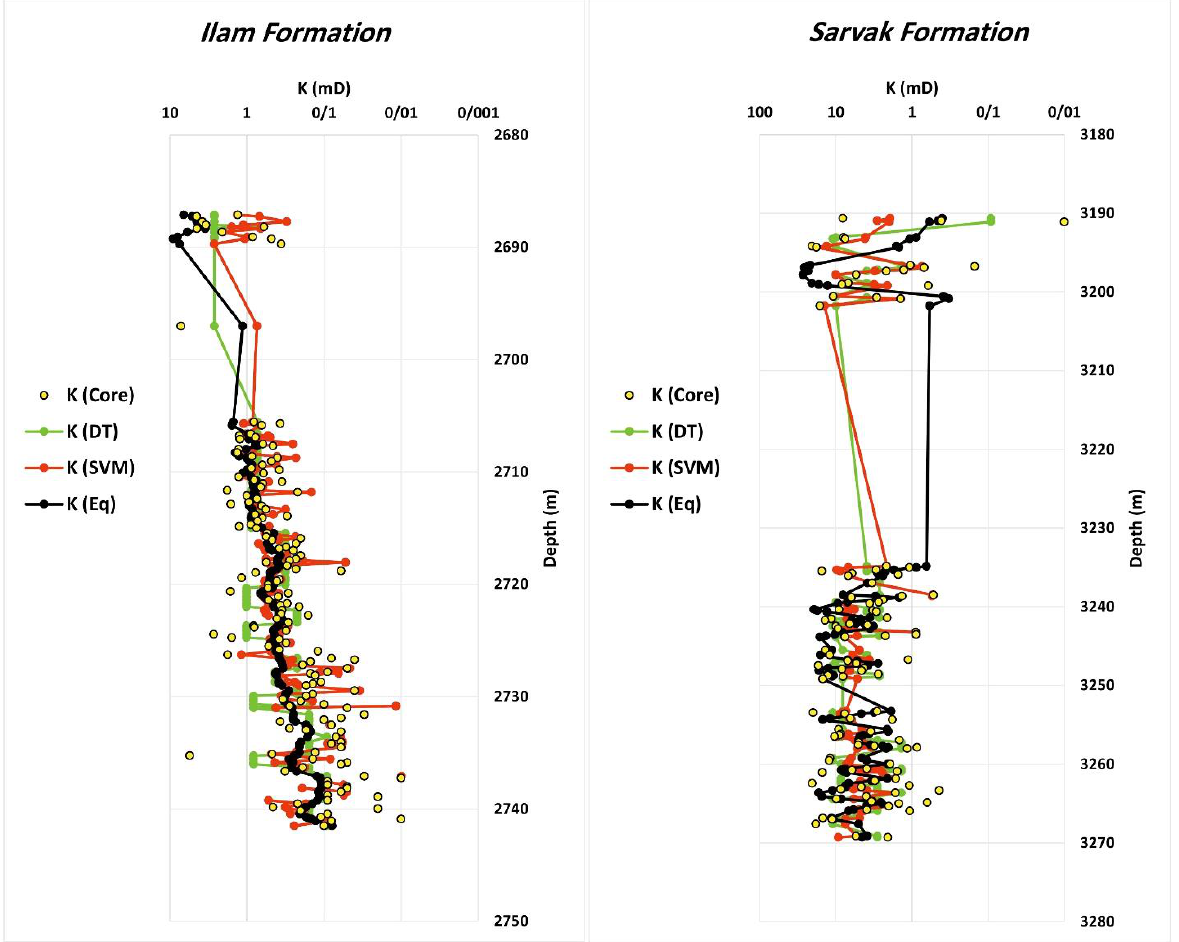
Figure 13. The variation of obtained permeability values by the empirical equation, SVM, and DT quantities with depth for Ilam and Sarvak